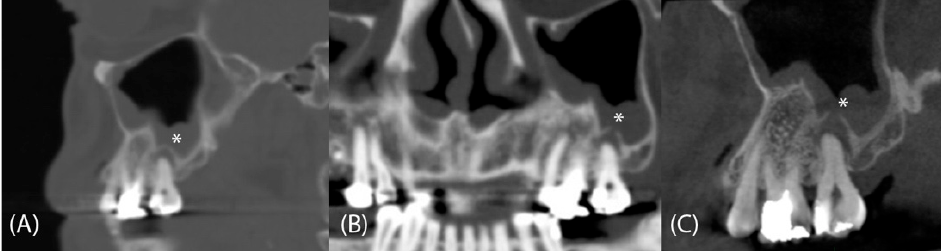
Figure 2. CPR and dental CBCT could identify more dental pathologies than conventional CT im- ages. ( A ) The parasagittal CT view identified a periapical lesion of a left maxillary molar (no. 27, asterisk); however, both ( B ) CPR and ( C ) CBCT revealed a co-existing fistula (*).